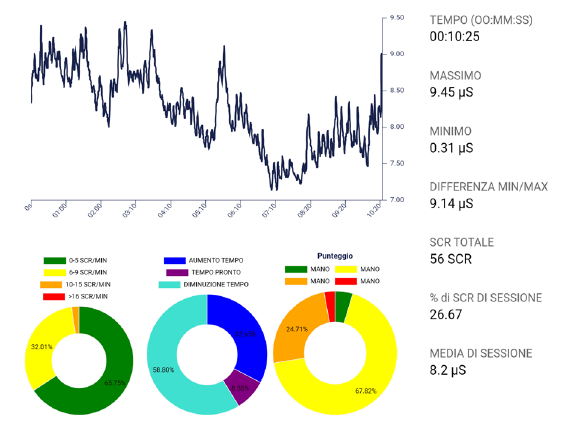
Figure 10. GSR data recorded through eSense